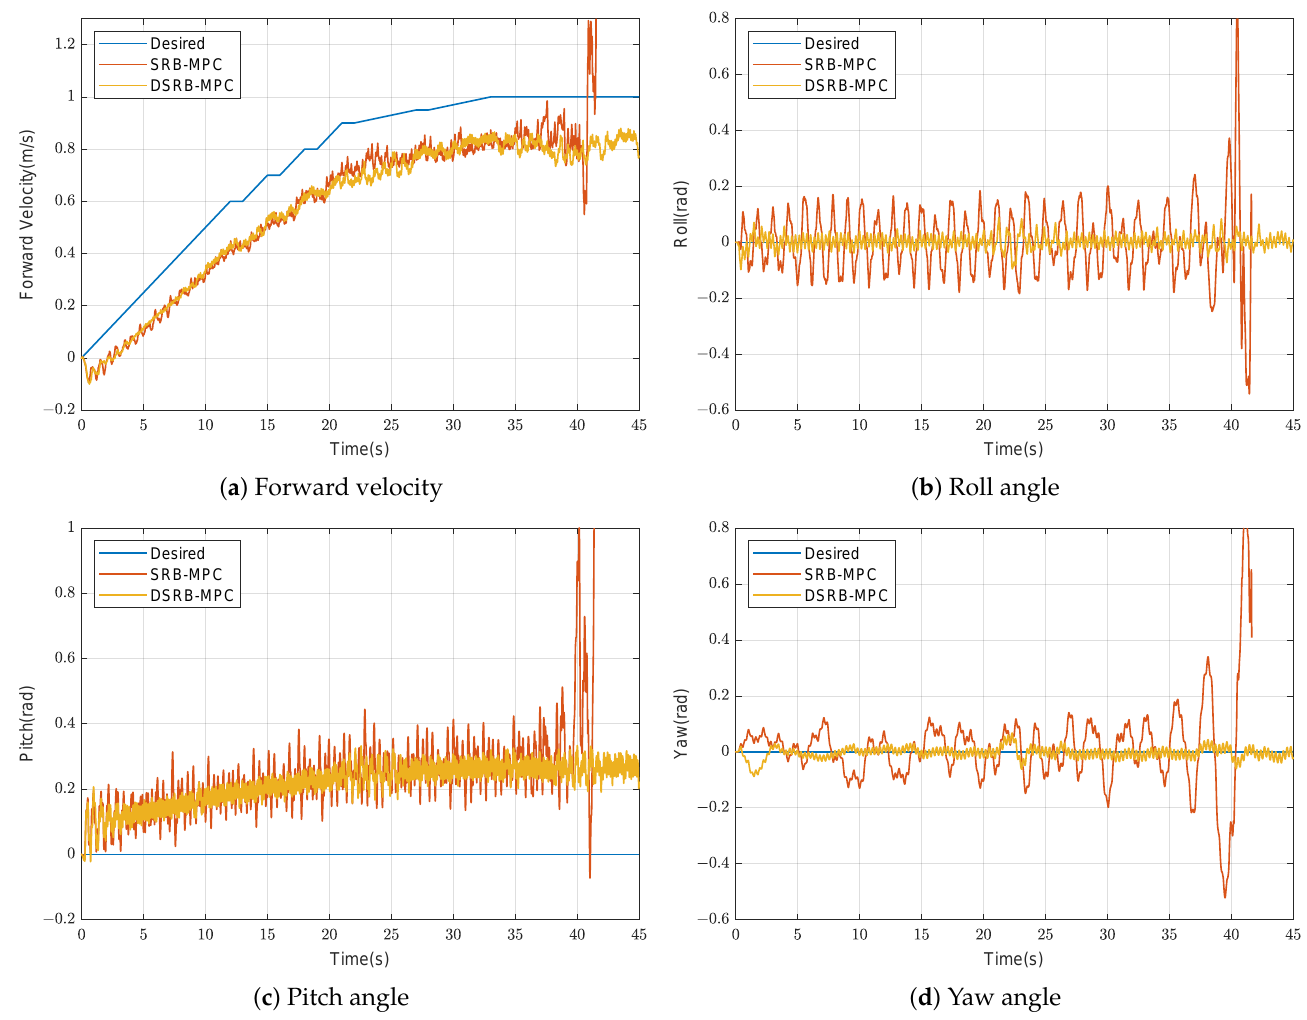
Figure 8. The performance of the target policy π . ( a ) The command velocity and measured actual velocities of are presented. ( b ) The command roll angle and measured actual roll angles are presented. ( c ) The command pitch angle and measured actual pitch angles are presented. ( d ) The command yaw angle and measured actual yaw angles are presented. Note that all blue lines represent given reference signals. Red lines show the performance of SRB-MPC. Yellow lines show the performance of DSRB-MPC. The red line stops because the error of SRB-MPC exceeds the maximum error, the simulation stops at about 40 s. The reason for the instability of SRB-MPC is that the disturbances of the swinging leg are not considered in the modeling, and the modeling error is too large. In this situation, modeling errors for Θ and p are too large, and MPC cannot resist. However, DSRB-MPC can accurately model disturbances and resist